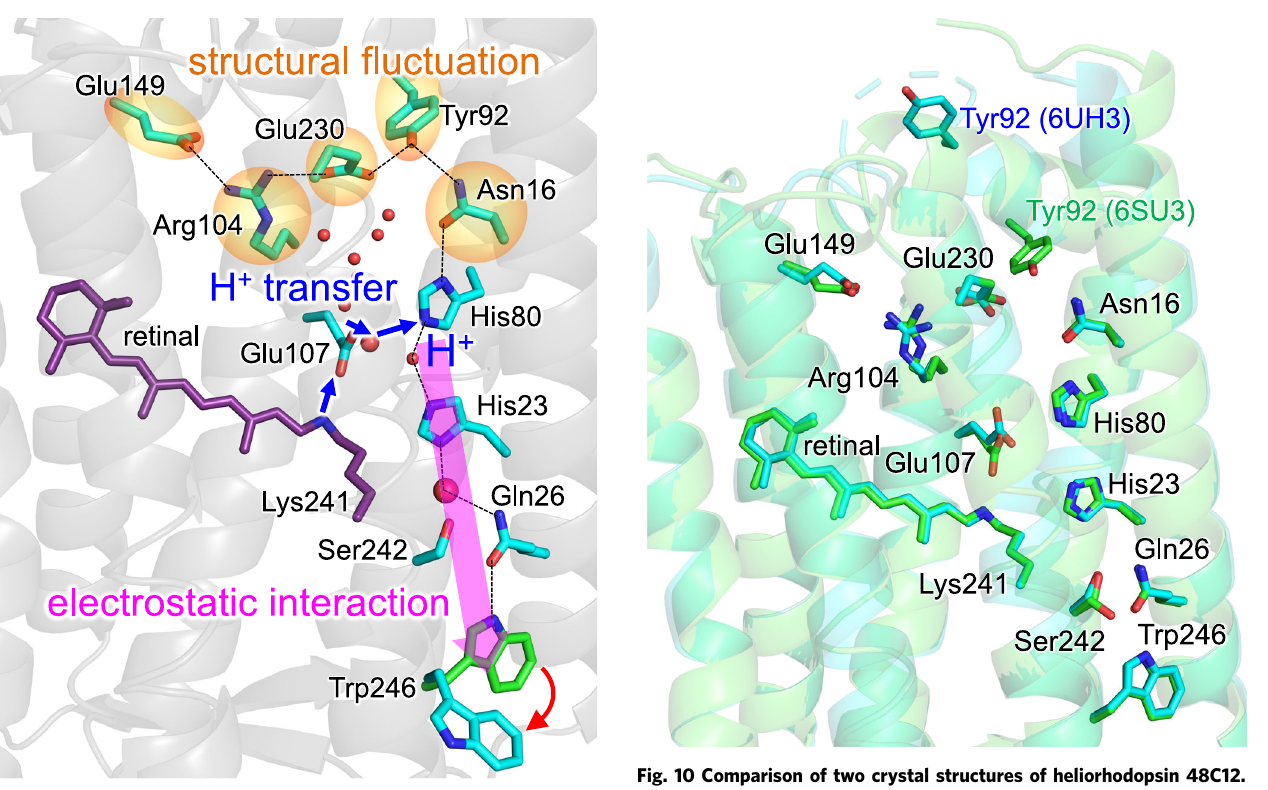
Fig. 9 Mechanism of the proton-mediated structural changes in heliorhodopsin. Blue arrows indicate proton transfer. The pink thick arrow indicates the electrostatic interaction along the H-bond network. The red curved arrow indicates the Trp-in to Trp-out conformational change.